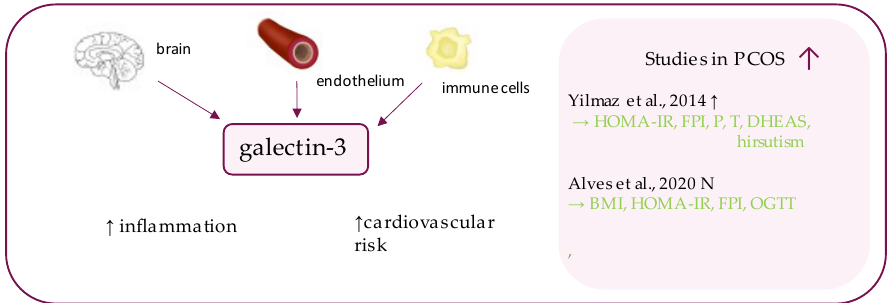
Figure 6. Role of galectin-3 in the pathogenesis of insulin resistance and PCOS. List of the studies assessing galectin-3 level in serum of the patients with PCOS. ↑ /N indicates whether concentration level of galectin-3 was increased/ unchanged in PCOS individuals ( p < 0.05); → (green)—indicates positive correlation between serum galectin-3 and particular indicators; HOMA-IR—Homeostatic Model Assessment for Insulin Resistance, FPI—fasting plasma insulin, P—progesterone, T—testosterone, DHEAS—dehydroepiandrosterone sulphate, BMI—body mass index, OGTT—oral glucose tolerance test .